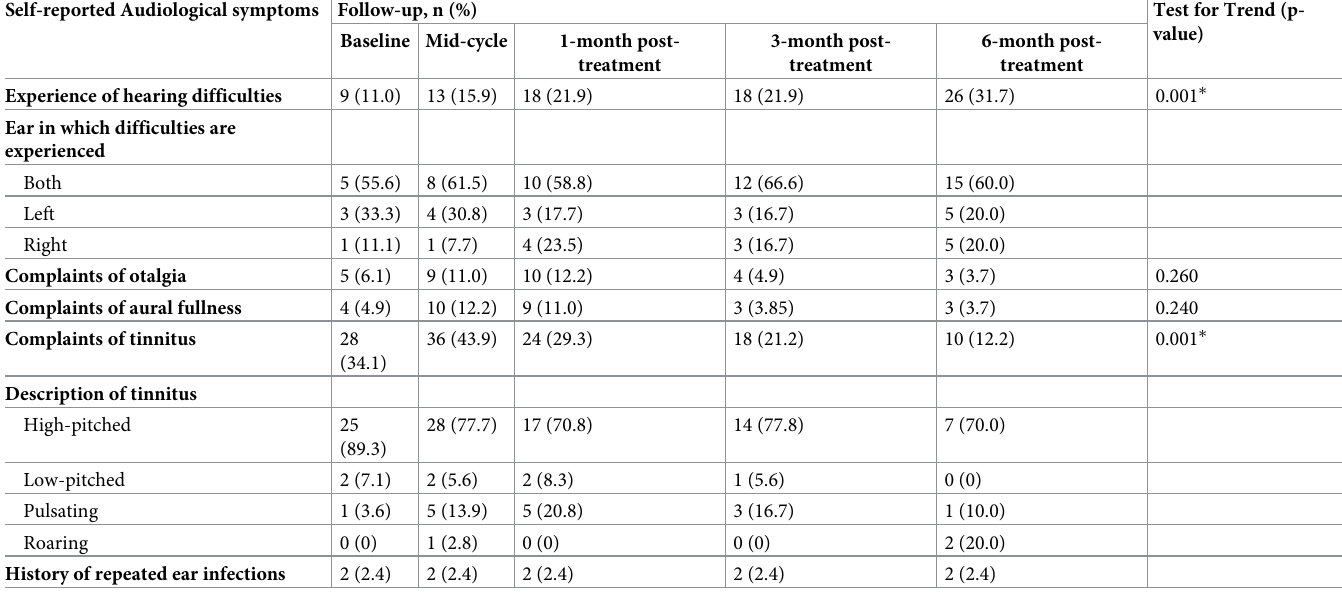
Table 2. Self-reported audiological